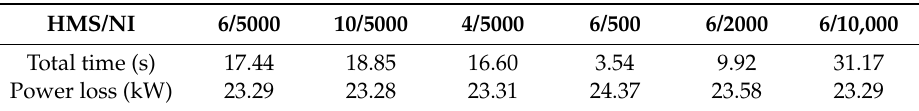
Table 6. Comparison of HSA results under different settings in Scenario